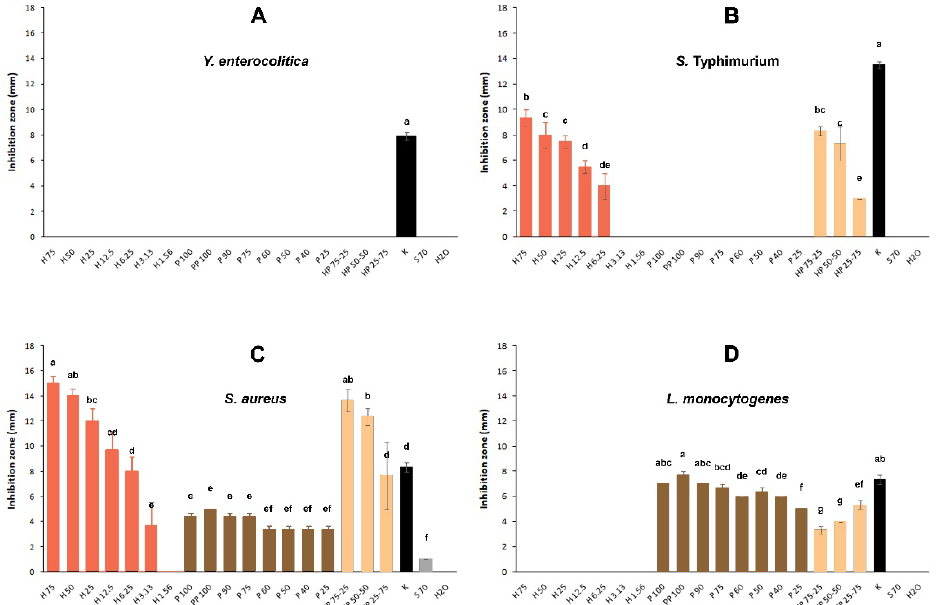
Figure 2. Inhibition zones (mm) of samples against the four bacterial species: ( A ) Y. enterocolitica ; ( B ) S. Typhimurium ; ( C ) S. aureus ; ( D ) L. monocytogenes . H: honey (100% v / v ), P: propolis tincture (100% v / v ), PP: purified propolis tincture. Numbers indicate the concentration (% v / v ) of each sample. HP: honey and propolis mixtures at the ratios indicated. K: Kanamycin, S70: Solvent (EEVBP) 70% ( v / v ), H 2 O: sterile distilled water. Mean values followed by different superscript letters (a–g) significantly differ ( p < 0.05).